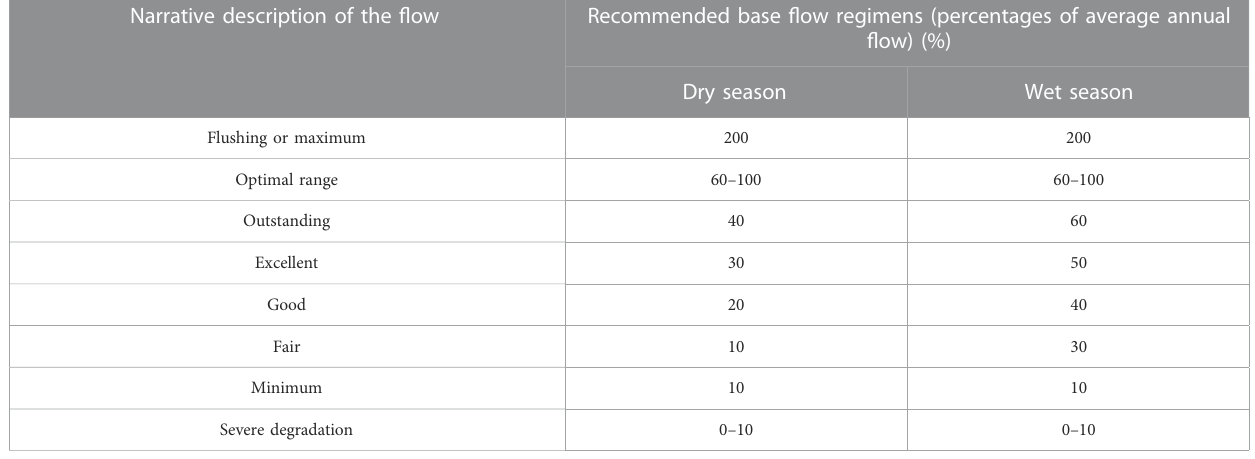
TABLE 5 Calculating ecological fl ow assessment criteria in the Tennant method.